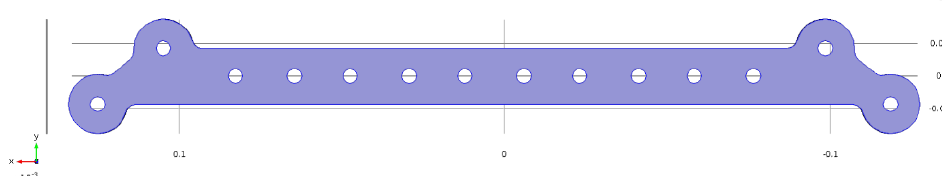
Figure 4. Fixed constraint on the developed plate.